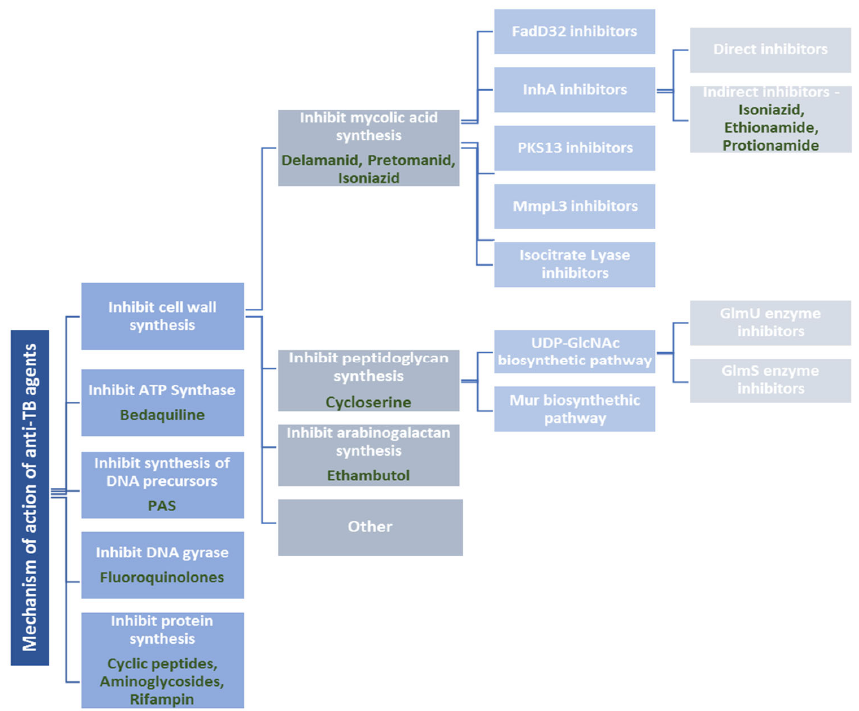
Figure 3. Mechanisms of action of the currently available anti-tuberculosis drugs